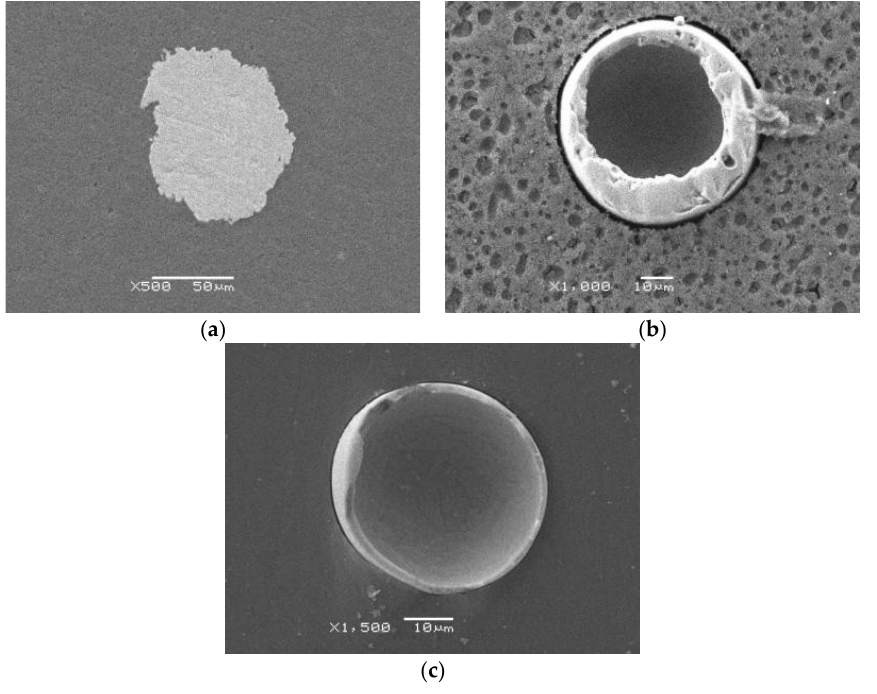
Figure 3. SEM images of the cross ‐ section of YSZ particles. ( a ) YSZ agglomerated powder; ( b ) HS1; and ( c ) HS2.